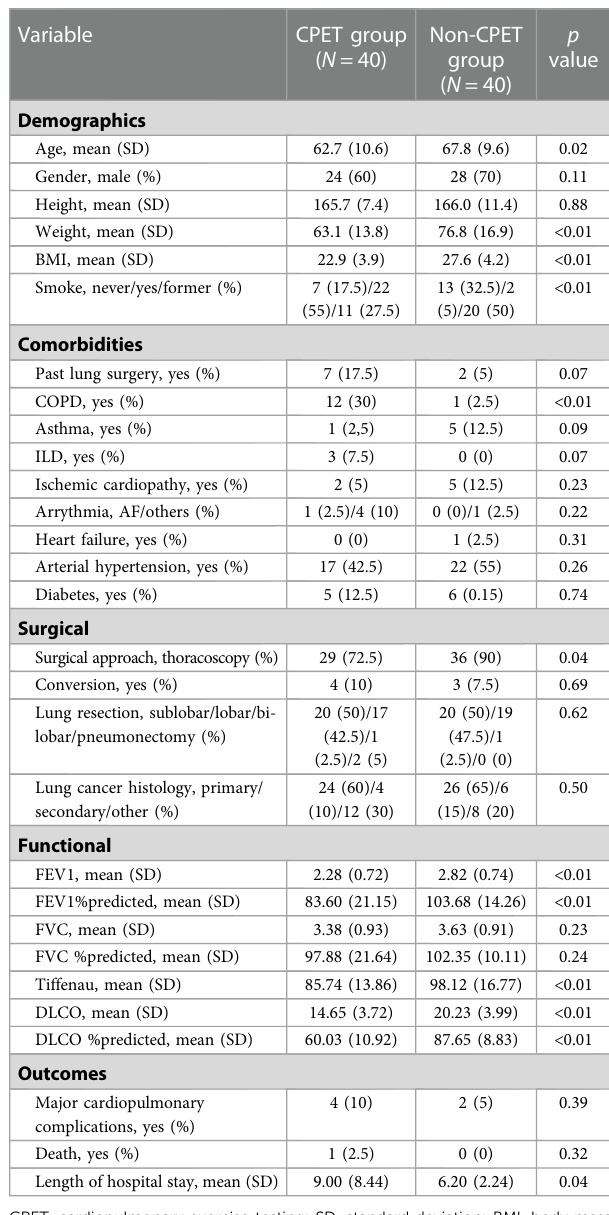
TABLE 1 Patients ’ characteristics and comparison between patients with functional pulmonary impairment assessed by CPET (CPET group) and patients without functional pulmonary impairment (non-CPET group). Statistically signi fi cant variables are in